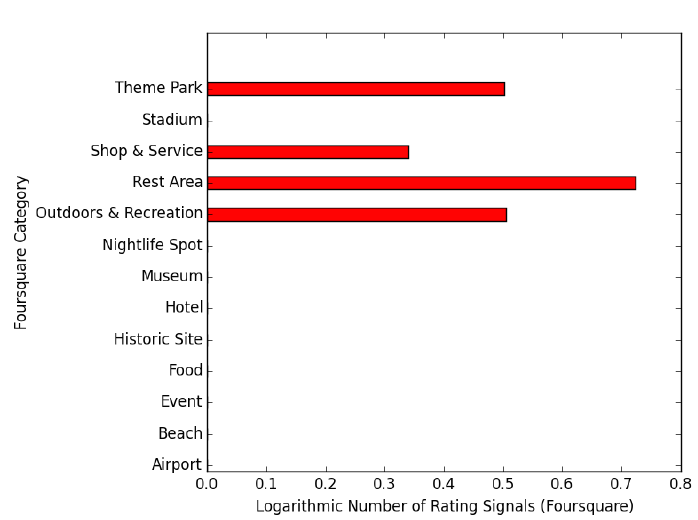
Figure 11. Characteristics of a neighborhood (Nagashima Spa Land): One of the biggest theme parks in the world fails to attract foreign tourists because it lacks Nightlife